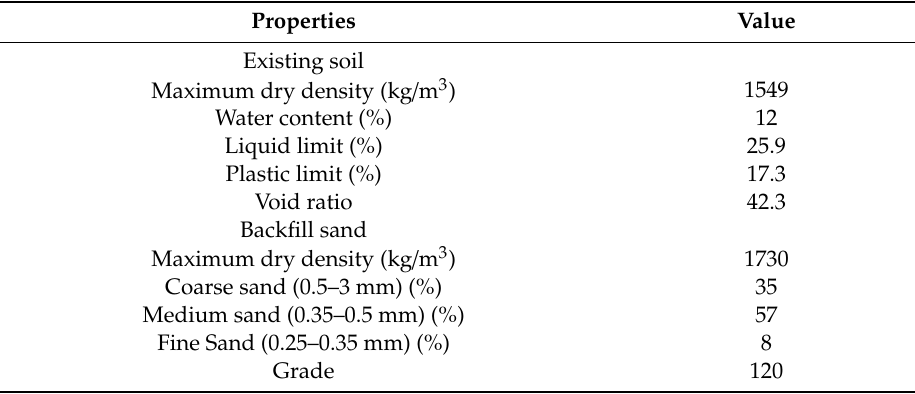
Table 8. Physical and mechanical properties of the field test soil.